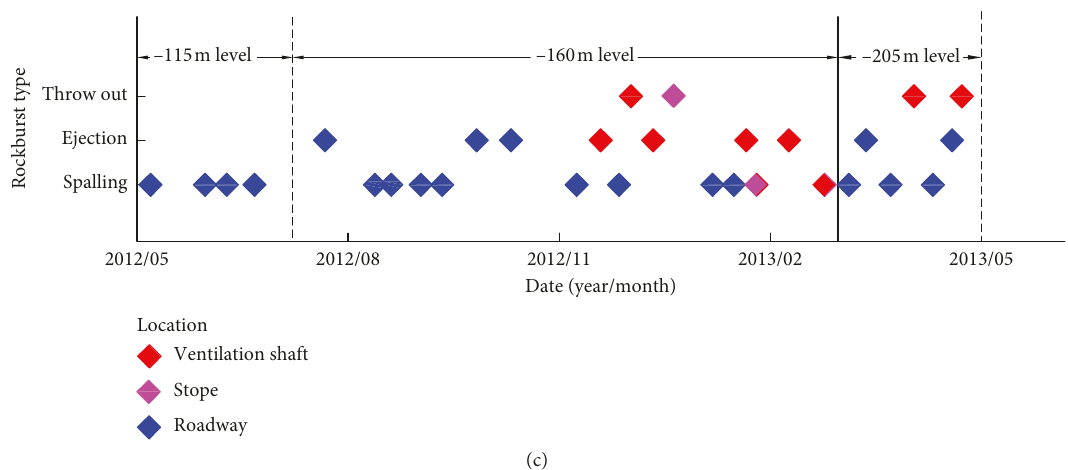
Figure 16: Verification of rockburst events between May 2012 and May 2013. (a) Rockburst type and strain elastic energy. (b) Rockburst type and lithology. (c) Rockburst type and